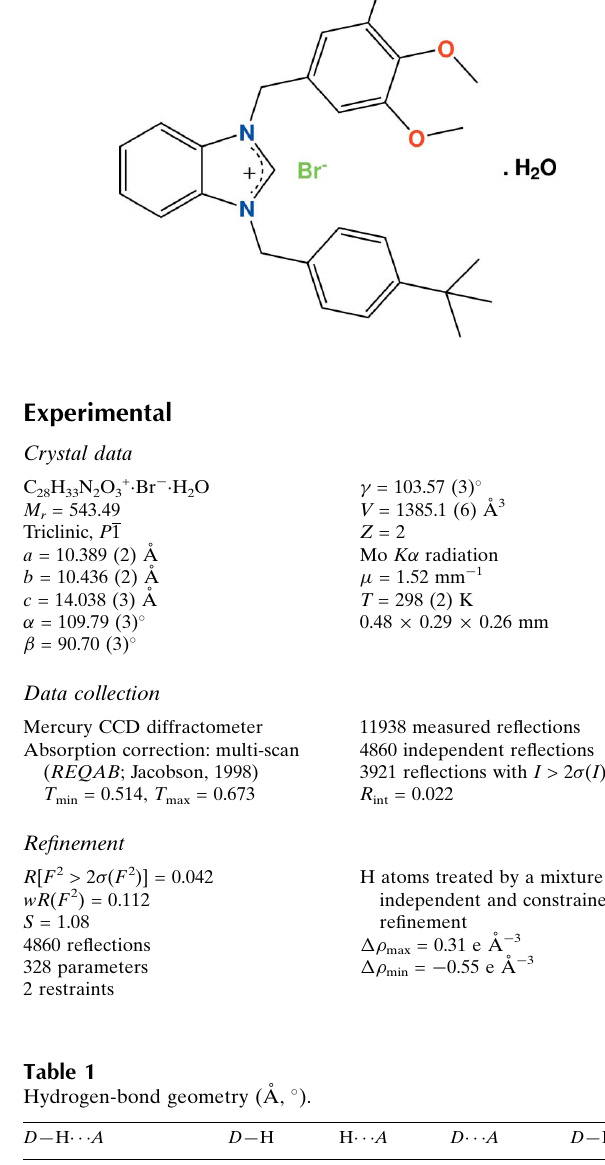
Hydrogen-bond geometry (A ˚ , (cid:3) ). D —H (cid:1)(cid:1)(cid:1)